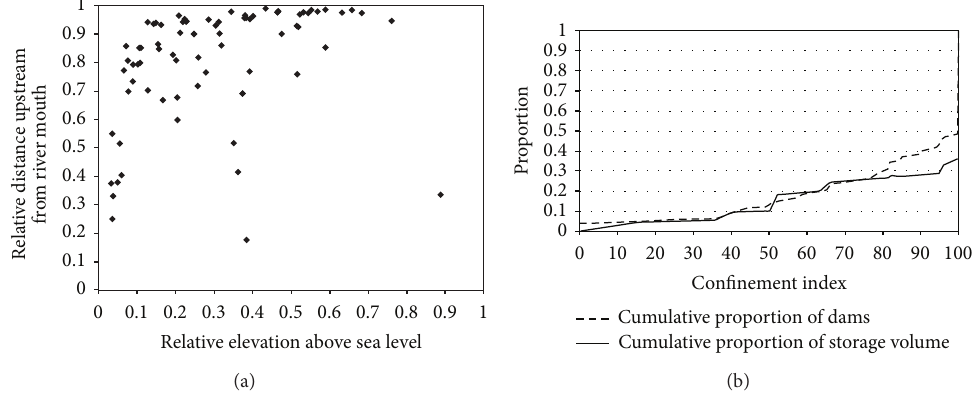
Figure 2: (a) Elevation and longitudinal position of dams in southeast Australian catchments (elevation is given as a proportion of the maximumelevationupstreamofthedamanddistanceupstreamoftherivermouthisexpressedrelativetothemaximumstreamdistancefrom the catchments headwaters to the river mouth). (b) Cumulative proportion of dam volume and dam count with increasing valley confinement in southeast Australia.